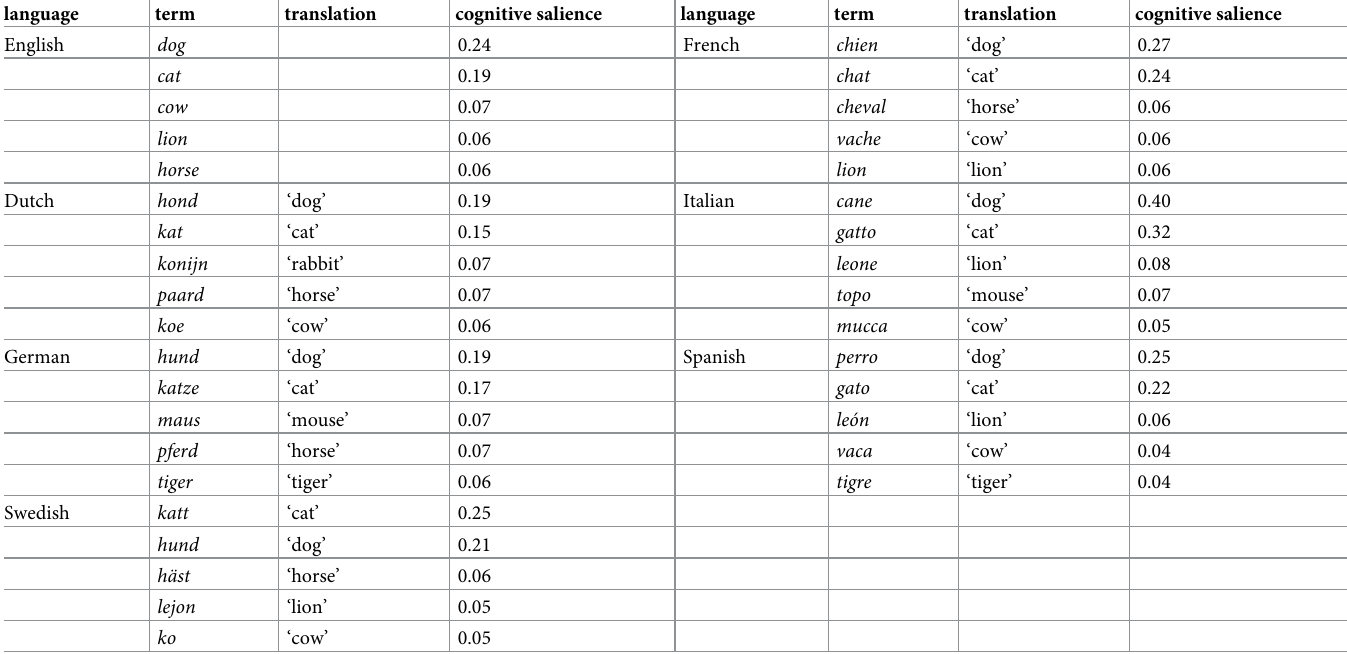
Table 3. The five most cognitively salient animal exemplars in each